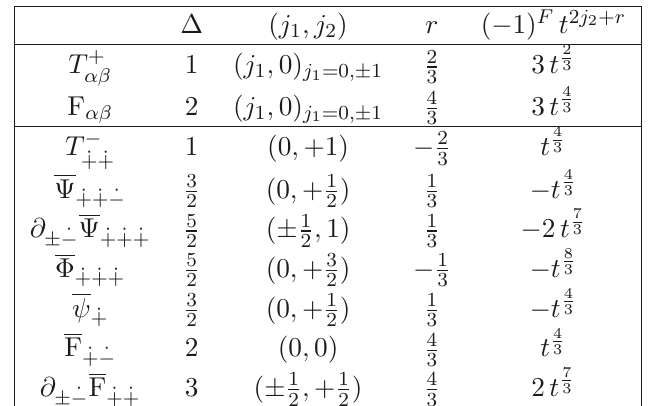
Table 5 . Contributions to the index of the [ 3